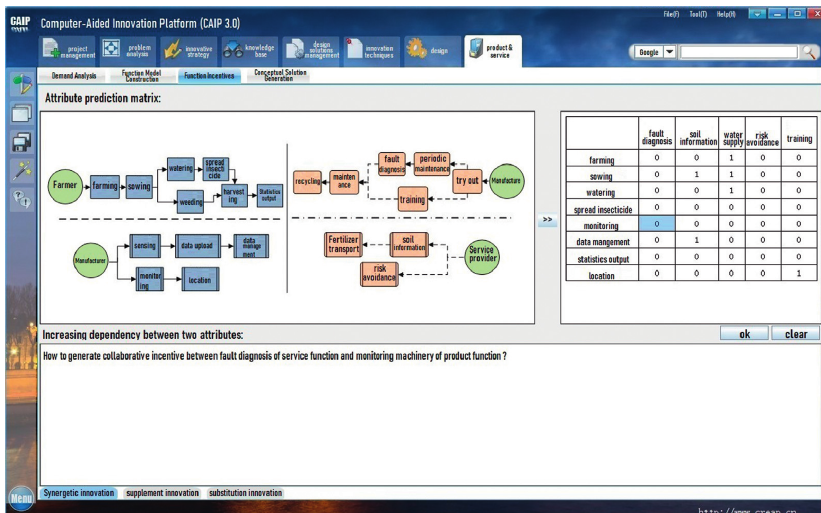
Figure 6: Function incentive selection submodule of the agricultural machinery PSS based on CAIP 3.0.